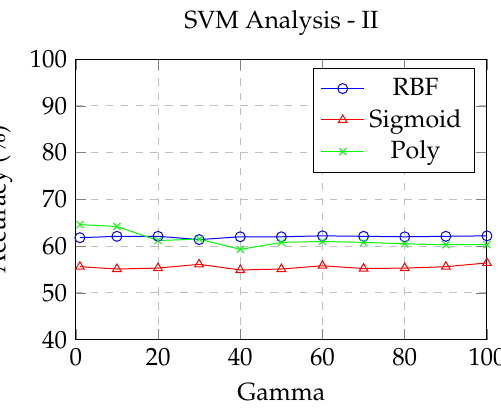
Figure 9. Analysis of SVM kernel accuracy for Protected